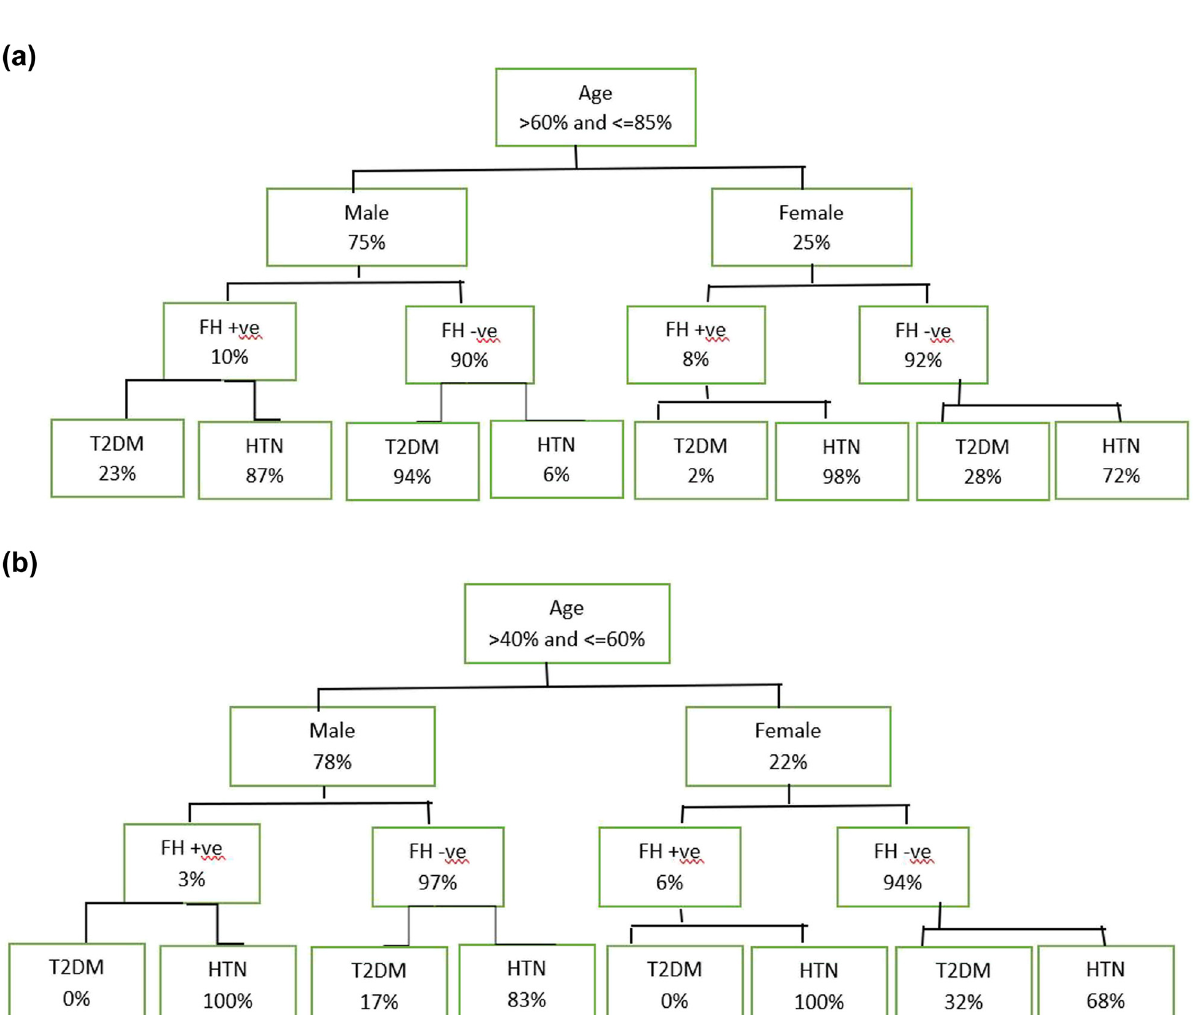
Figure 5: ( a ) Patients with heart disease between the ages of 60 and 85 are displayed as leaves on a tree. ( b ) Patients with heart conditions between the ages of 40 and 60 are displayed in a tree